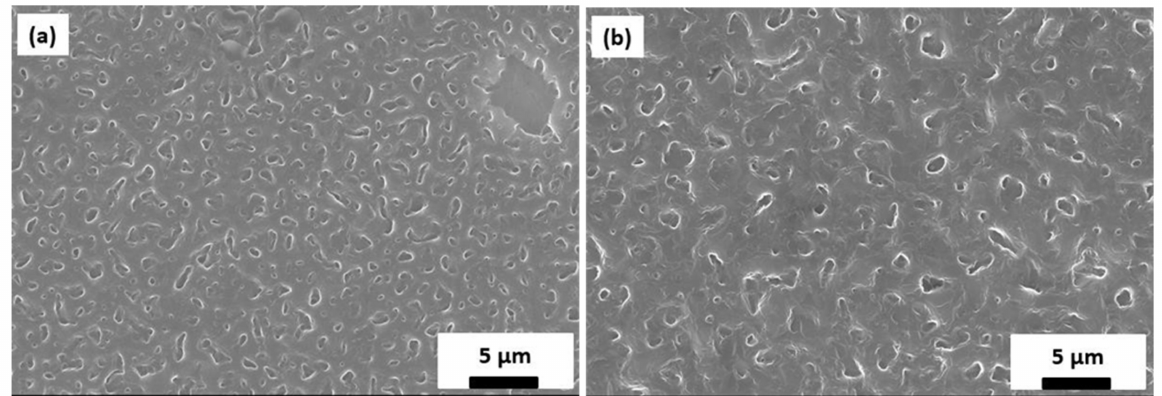
Figure 6. SEM micrographs of as-deposited pure Li layer surfaces fabricated by applying a plasma pre-treatment prior to coating. The pore size grows by increasing the substrate temperature from ≈ 50 ◦ C ( a ) to ≈ 150 ◦ C ( b